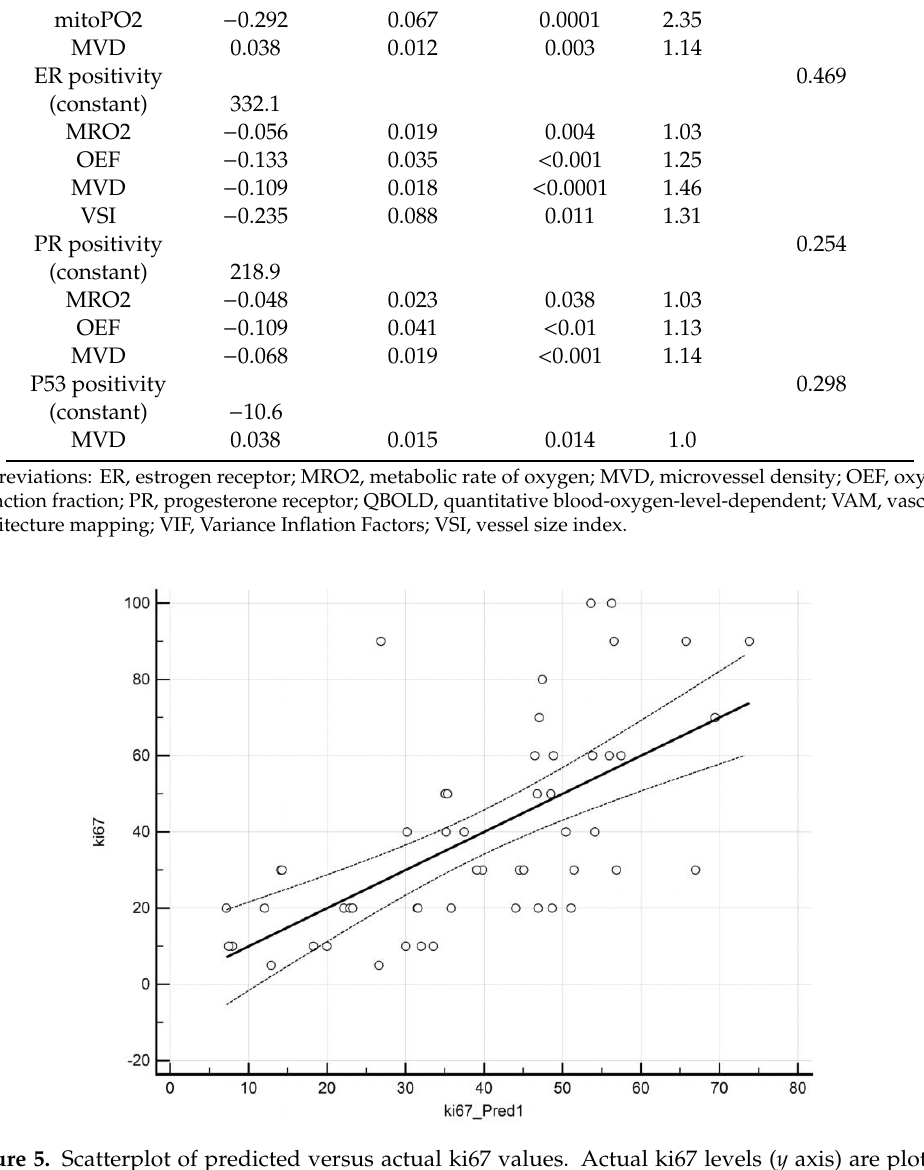
Figure 5. Scatterplot of predicted versus actual ki67 values. Actual ki67 levels (y axis) are plotted against predicted ki67 values (x axis).